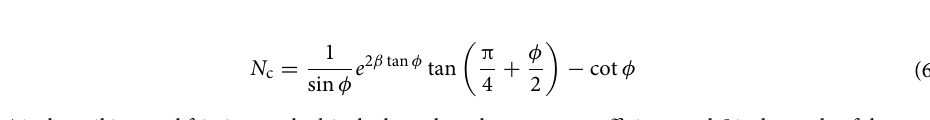
Table 1. Three microanchored fiber-optic cables developed for deformation sensing in the near surface environment. The optical fiber depicted in the cross-section illustration is comprised of a fiber core (silica core + cladding) and a coating. The unanchored strain sensing cables are commercially available (NanZee Sensing Ltd.): the TPU-jacketed (NZS-DSS-C07); the PE-jacketed (NZS-DSS-C02). Note that no anchor– cable interface debonding was found in any of the applications presented. TPU = thermoplastic polyurethane; PE = polyethylene. Refer to Ref. 35 for a cable with special three-dimensional “dead” anchors suitable especially for detection of shear deformation such as a creeping